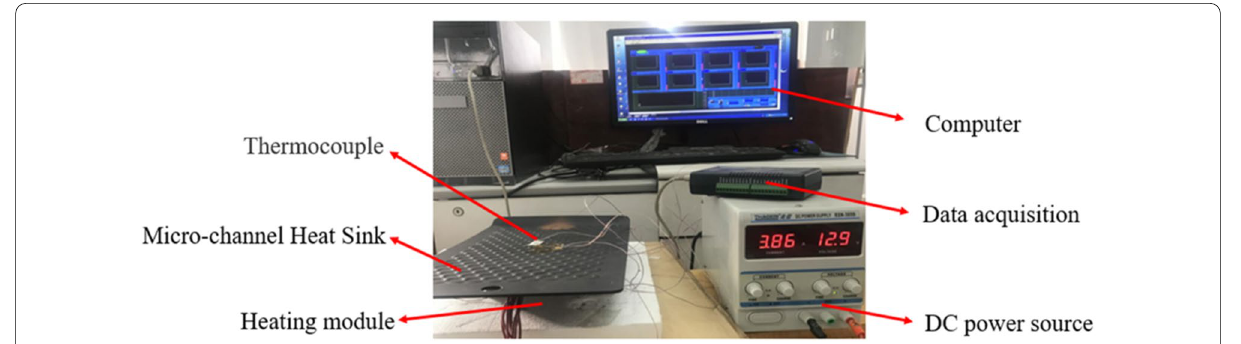
Figure 3 The heat transfer performance testing platform